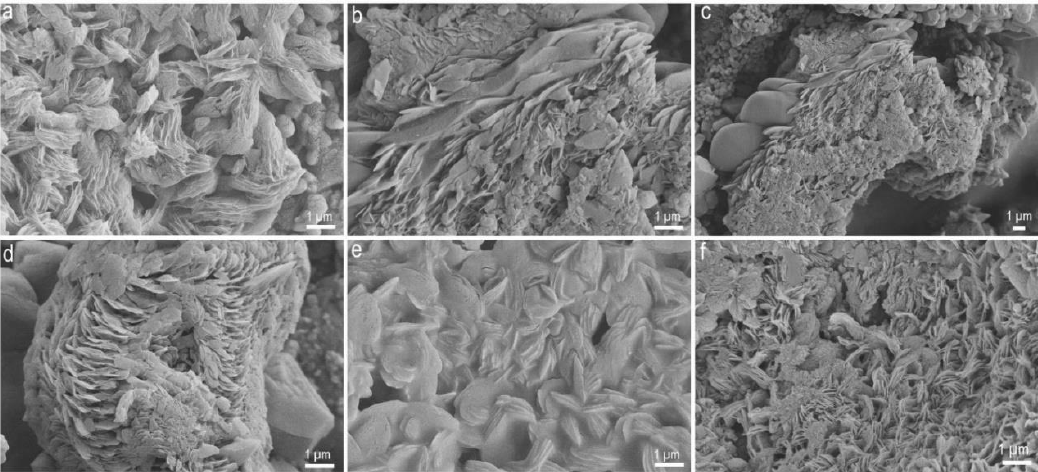
Figure 2. SEM images of residues obtained after shock processing of two amino acid mixtures (Table S1). ( a – c ) Short feather like features, ( d ) shows the formation of ordered scale features in a glycine-glutamic acid mixture, ( e ) rose petal like features in an asparagine–glutamic acid mixture and ( f ) short thread like features in a glycine-glutamic acid mixture.